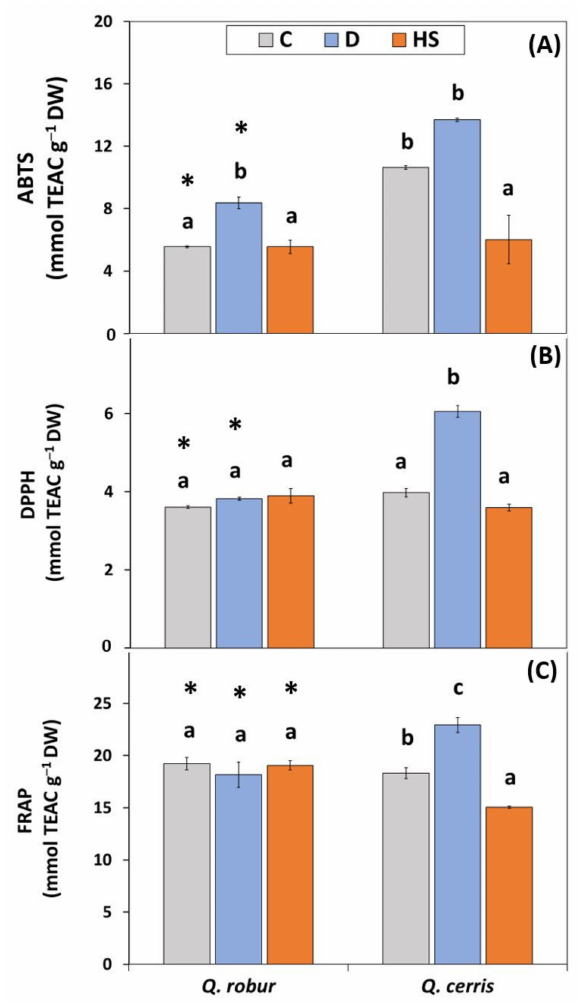
Figure 3. Total antioxidant capacity (mmol TEAC g − 1 DW) measured by: ( A ) ABTS; ( B ) DPPH; and ( C ) FRAP assay in leaves of Q. robur and Q. cerris . Abbreviations of the treatments, mean separation, and statistical treatments are as shown in Figure 1. Data represent the mean ± standard